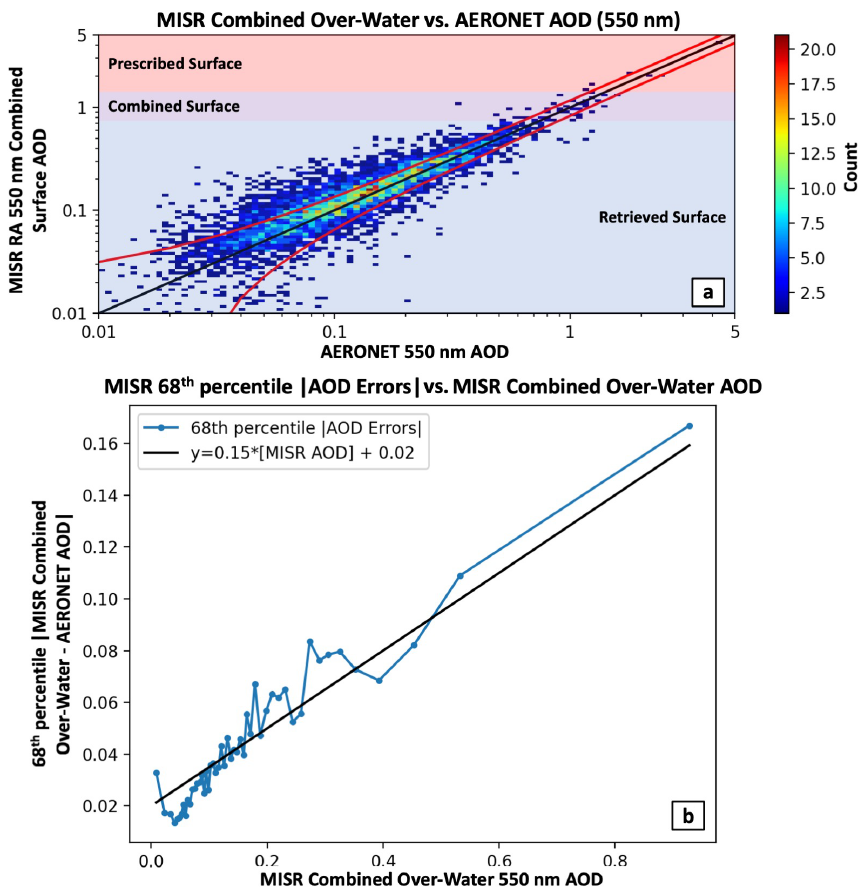
Figure 7. Same as Fig. 3, except for the MISR over-water